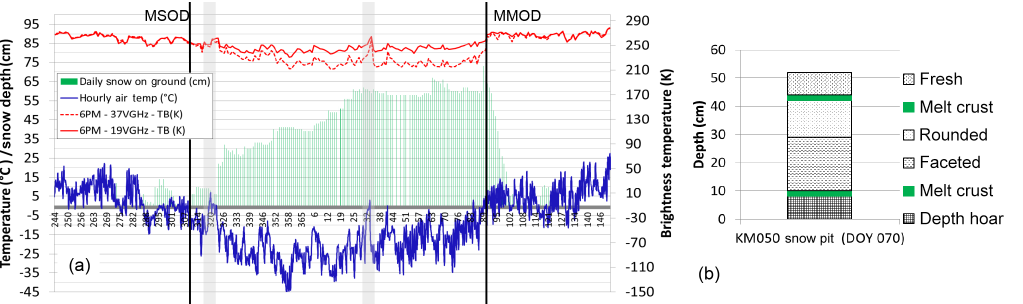
Figure 3. (a) Time series of hourly air temperature and daily snow depth and T B at the Thompson, Manitoba Meteorological Station from September 2004 to May 2005; the shaded grey bars highlight the timing of the melt events detected by the PMW satellite data. (b) Snow stratigraphy from the KM050 snow pit site surveyed on DOY097. Note that both the early season and recent melt crusts observed in the snow pit agree reasonably well with the timing of two winter melt events recorded at the Thompson airport and detected by the PMW satellite data.